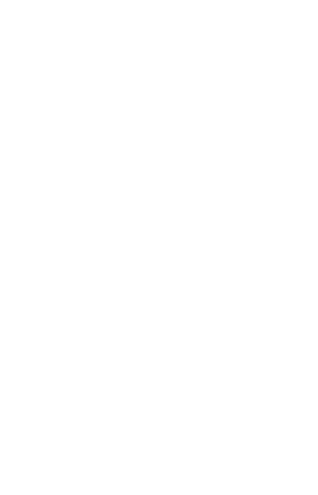
FIGURE 2 Camera and laser con fi guration for PIV